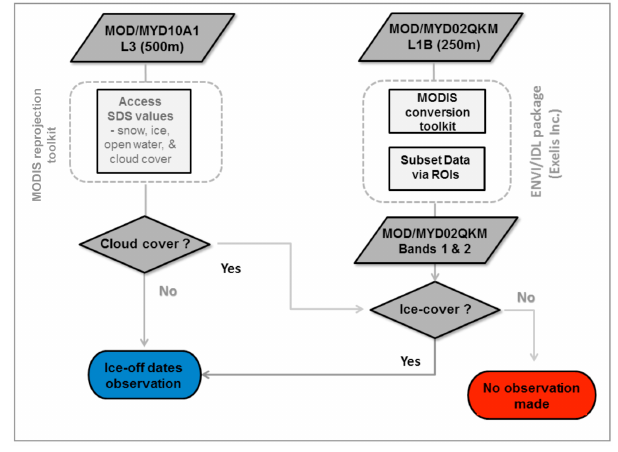
Figure 2. Illustration of the processing steps of ice of observations (manually and by visual interpretation) on the Mackenzie